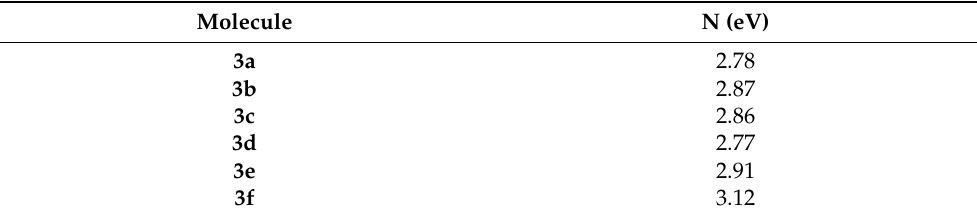
Table 6. B3LYP/6-311++G nucleophilicity N index, in eV, of tested molecules. Molecule